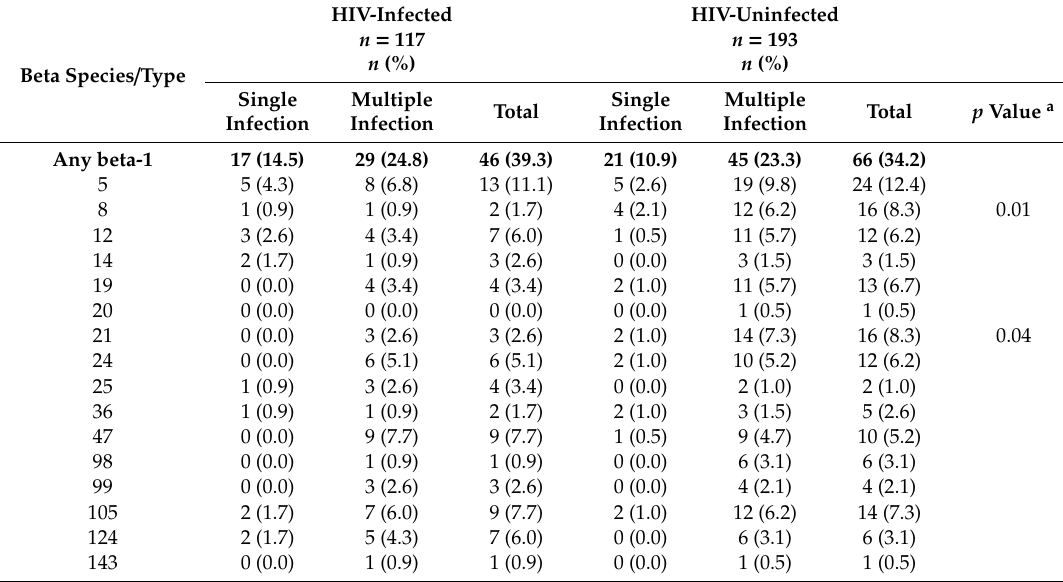
Table 3. Species-specific and type-specific prevalence of beta HPVs in single and multiple oral infections among the 310 MSM of the OHMAR study according to HIV